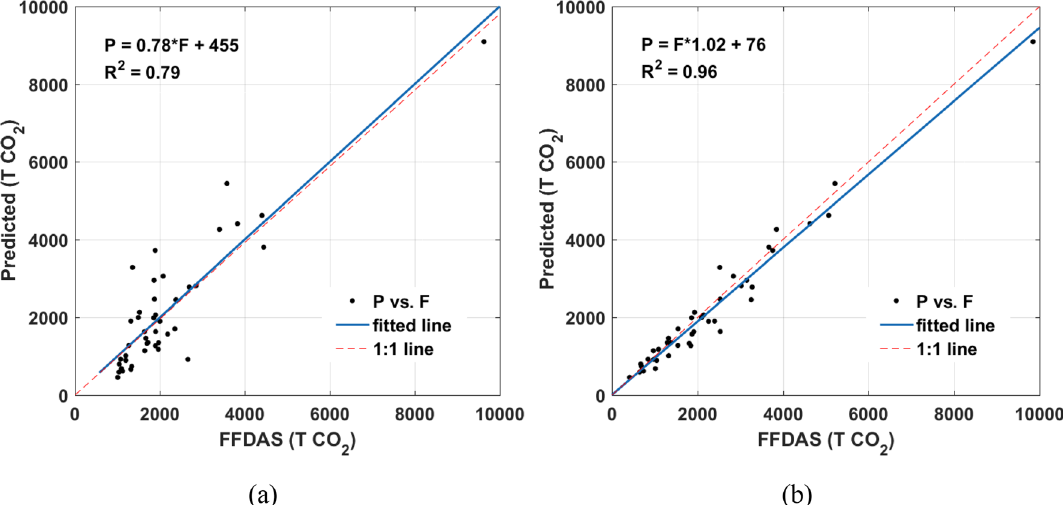
Figure 5. Trend line of the predicted (‘P’ for short) and FFDAS (‘F’ for short) data at selected city level, ( a ) Model 1, ( b ) Model 2. The figs were generated using the MATLAB software package (The MathWorks, Version 2013, https:// www. mathw orks.